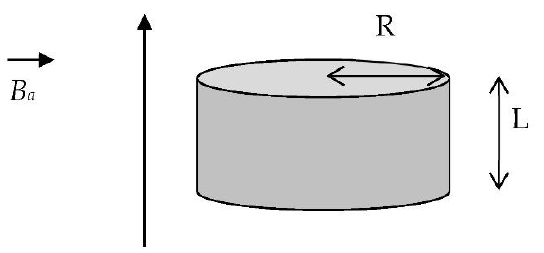
Figure 9. A cylindrical HTS bulk with its axis parallel to the applied magnetic